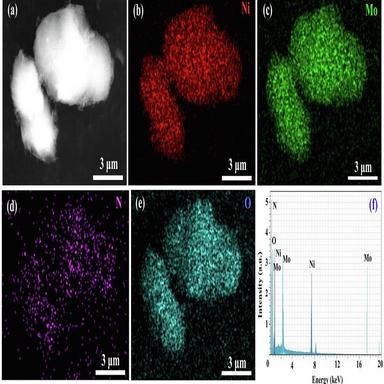
(Color online) SEM image (a), elements mapping (b–e) and EDS line scan curve (f) of NiO@NiMoO4@Ppy.